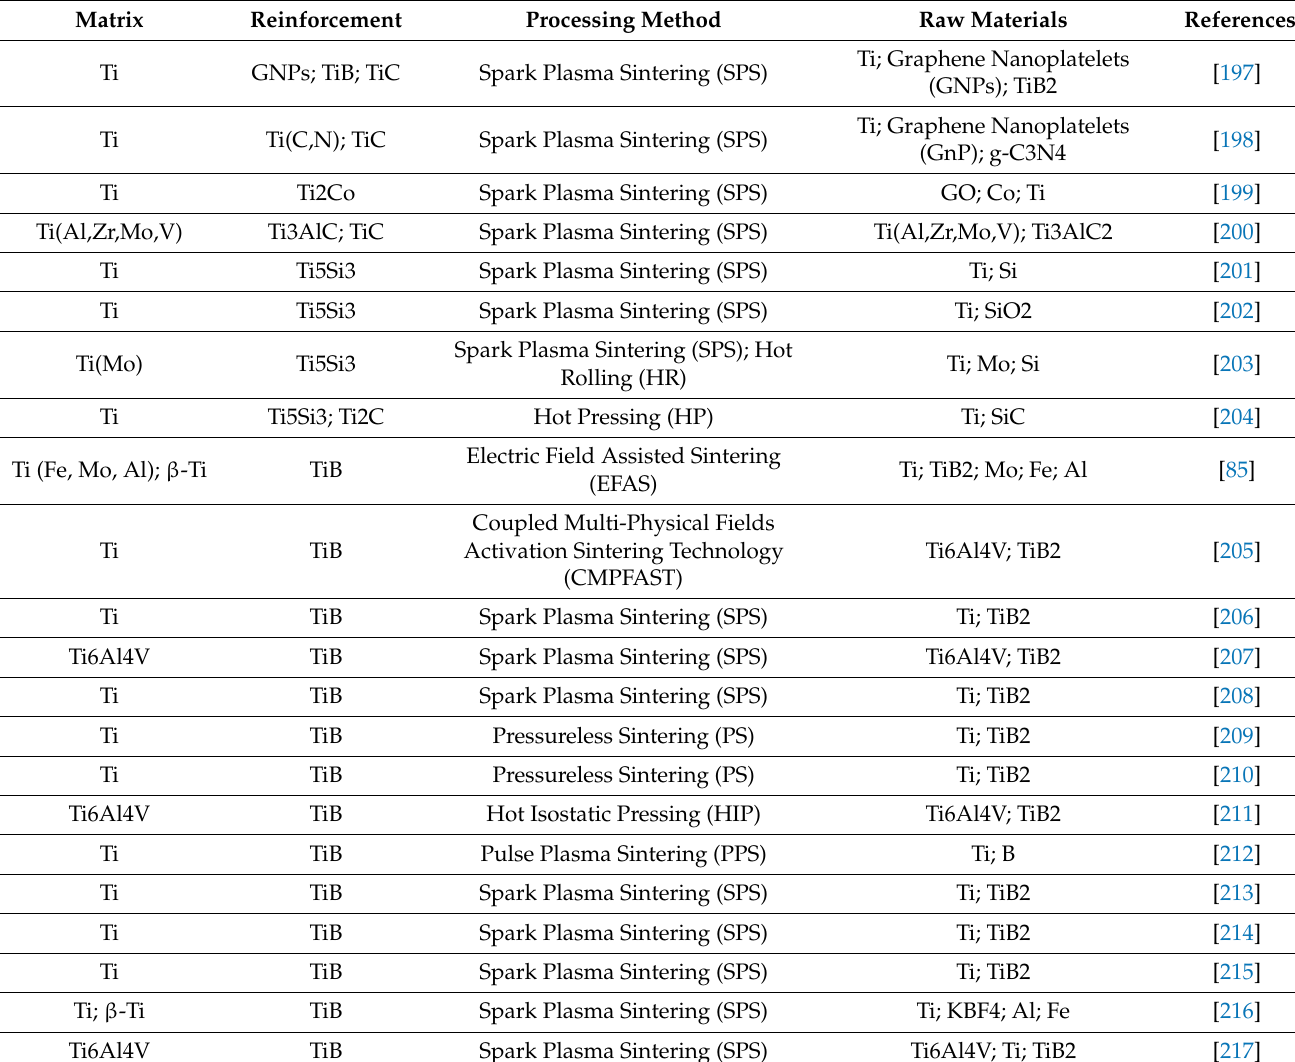
Table A3. Titanium Matrix